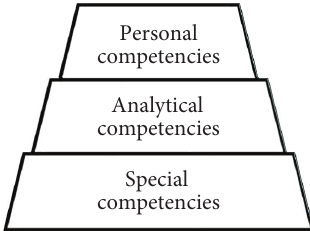
Figure 1. Competence groups of logistics specialists (compiled by the